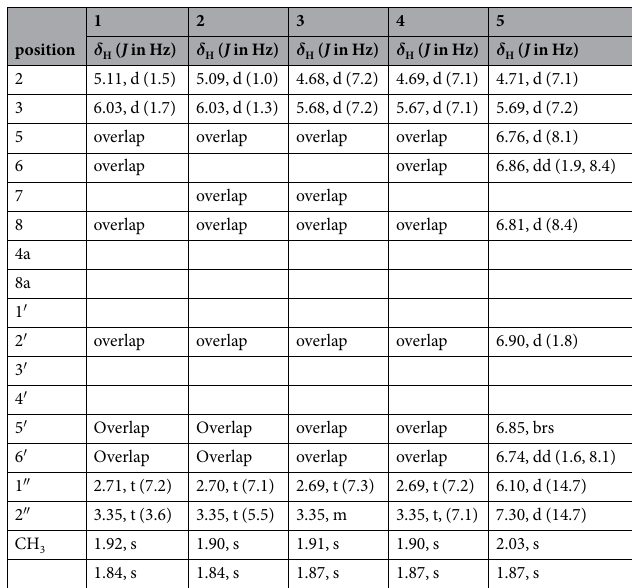
Table 1. 1H NMR Spectroscopic Data (600 MHz, methanol- d 4 ) for Compounds 1–5